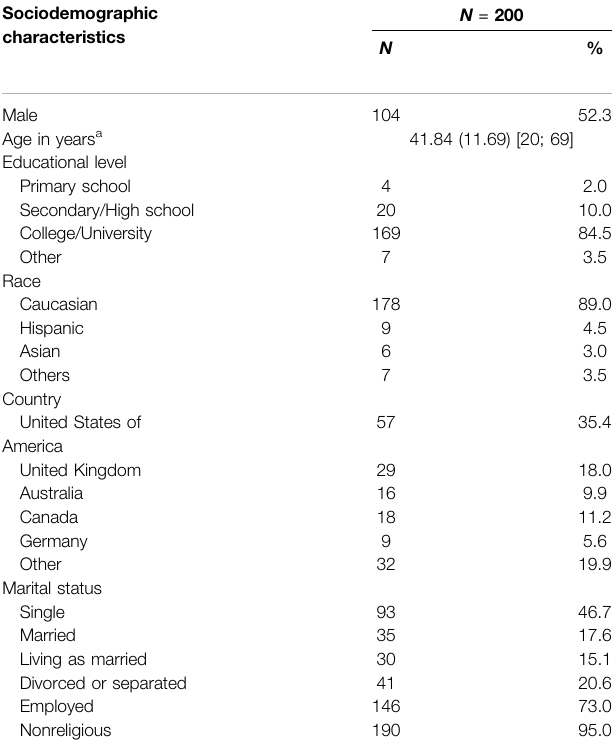
TABLE 1 | Demographic characteristics of